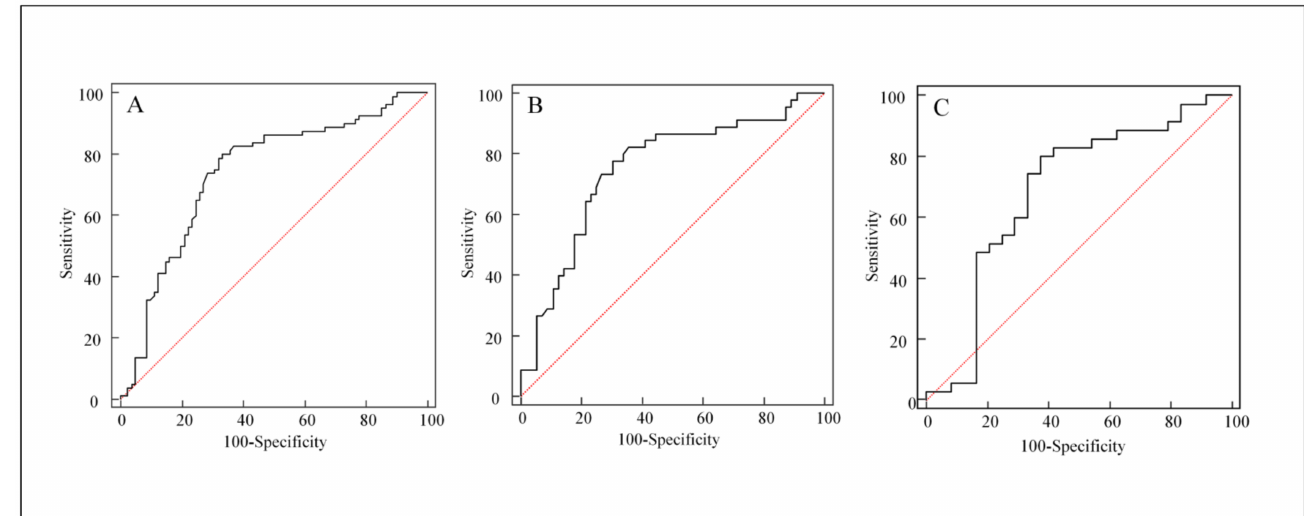
Figure 4. ROC curves for predictability of ∆ ALP ratio to distinct flare phenomenon from progressive disease. The cutoff value was a ∆ ALP ratio of 10% related to a definition of “increasing ALP,” not a Youden index. ( A ) In all patients, the ROC curve shows 0.735 of the area under curve (AUC), 80.0% sensitivity, and 63.8% specificity ( p < 0.0001). ( B ) In breast cancer patients, the ROC curve shows 78.8% sensitivity and 66.1% specificity (AUC = 0.750, p < 0.0001). ( C ) In prostate cancer patients, the ROC curve shows 82.9% sensitivity and 58.3% specificity (AUC = 0.686, p =